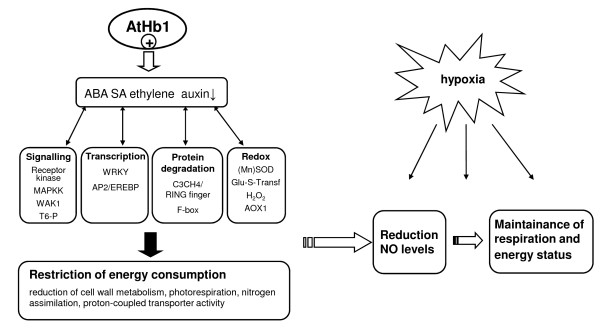
Hypothetical model of pathways coordinated by AtHb1 overexpression and its effects on hypoxic stress responses. Differences compared to WT as deduced from transcriptome, metabolite and physiological analyses are highlighted.